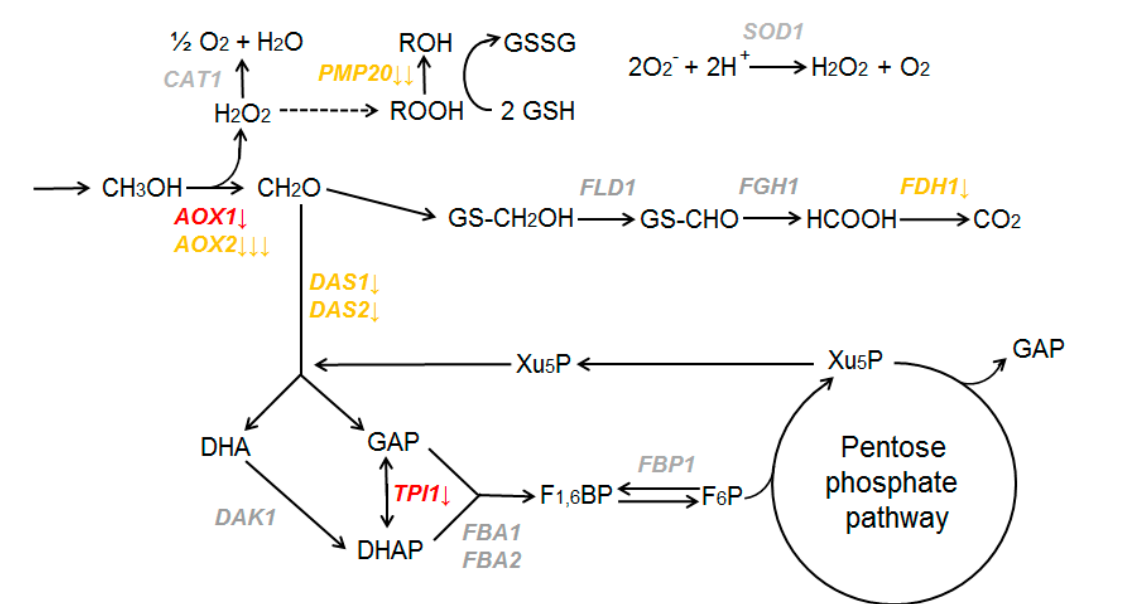
Figure 4. Scheme of the canonical methanol utilization pathway in K. phaffii cells (modified from [47]). Genes are placed near the reactions catalyzed by the corresponding proteins. Genes that are repressed in media with methionine are marked in orange (p adj < 0.05) and red (0.05 < p adj < 0.1). Genes that do not change their expression are marked in grey. The number of arrows represents values of the log2FoldChange parameter: one arrow 0.5 < log2FoldChange < 1; two arrows 1 < log2FoldChange < 2; three arrows 2 < log2FoldChange. Abbreviations of metabolites: DHA, dihydroxyacetone; DHAP, dihydroxyacetone phosphate; FRU 1,6 BP, fructose-1,6-bisphosphate; F 6 P, fructose-6-phosphate; GAP, glyceraldehyde-3-phosphate; GSH, glutathione; GSSG, oxidized glutathione self-dimer; Xu5P, xylulose 5-phosphate.